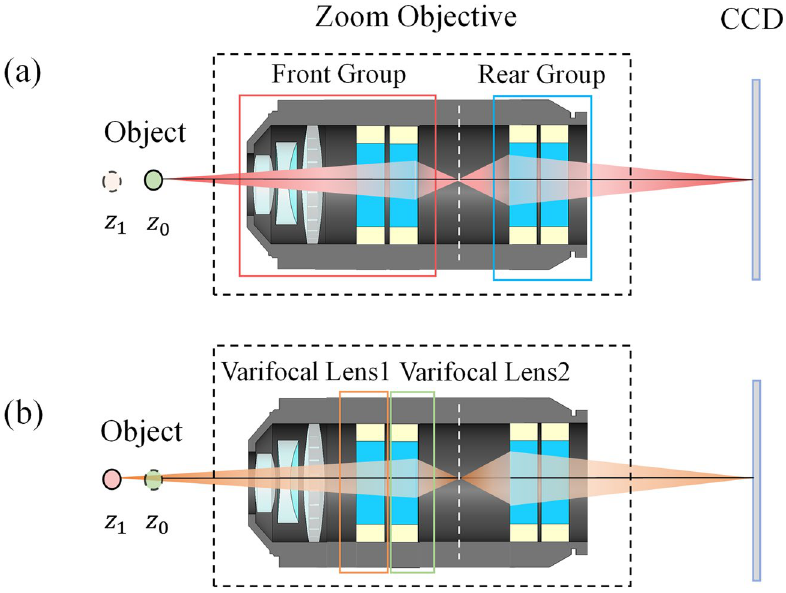
Figure 2. Simplified schematic diagram of the proposed microscope objective. ( a ) Focusing on the plane z 0 . ( b ) Focusing on the plane z 1